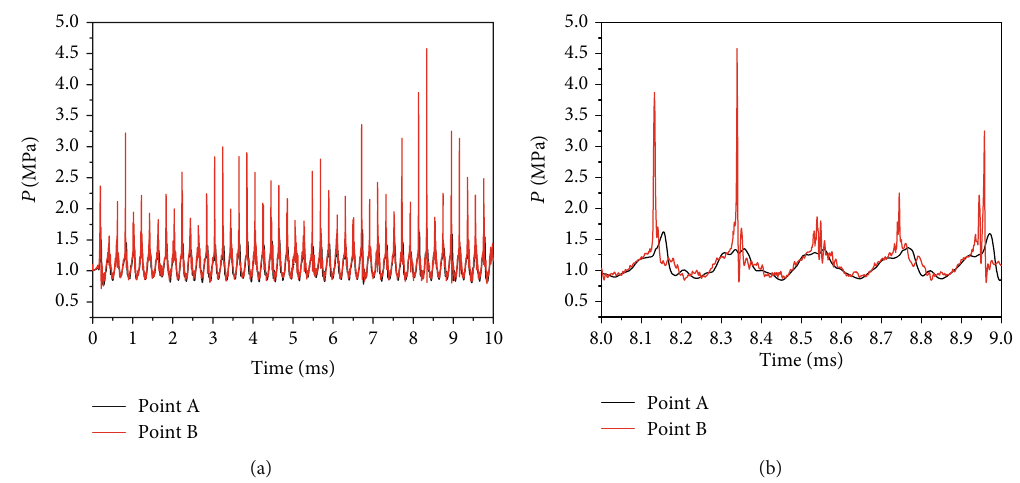
Figure 8: Pressure traces at Point A and Point B. (a) Pressure oscillations. (b) Pressure oscillations from 8ms to 9 ms.